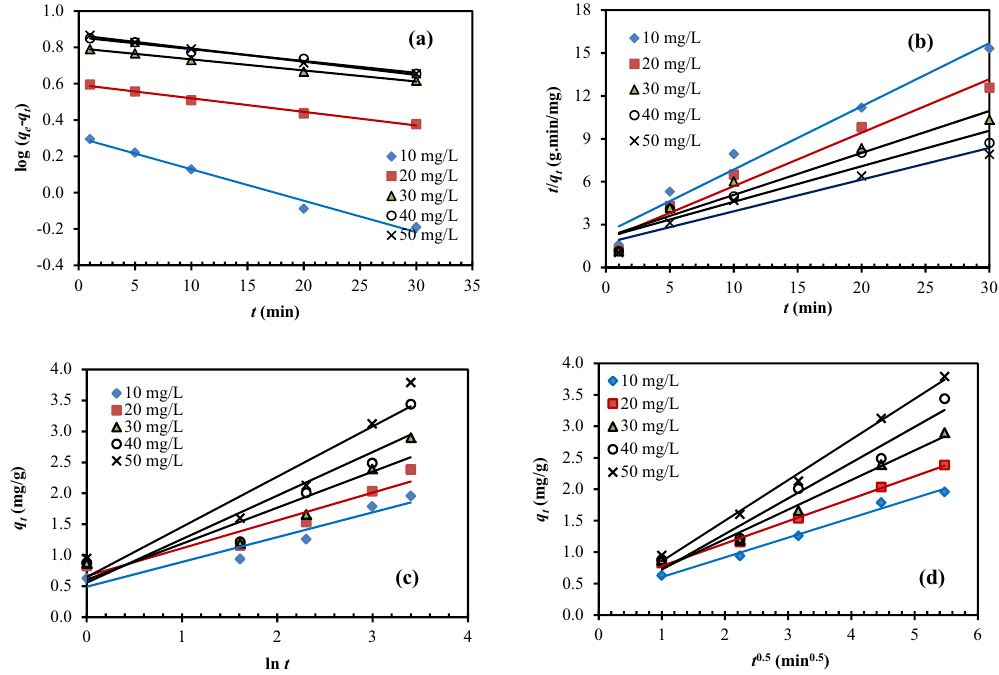
Figure 6. Kinetic plots for adsorption of Pb(II) on H 2 SO 4 -treated CNS at various initial concentrations, C 0 = 10–50 mg/L: ( a ) pseudo-first order model, ( b ) pseudo-second order model, ( c ) Elovich model, ( d ) Intra-particle diffusion